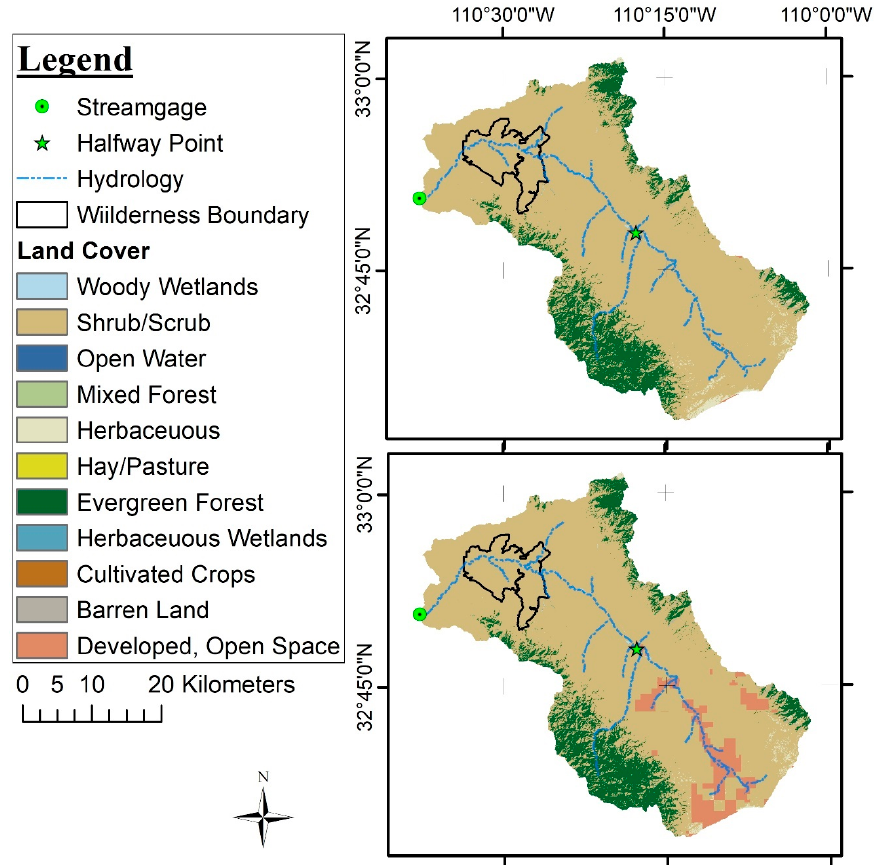
Figure 5. Current ( top ) and developed ( bottom ) land use inputs for SWAT (Soil and Water Assessment Tool) scenario assessment, modified from the NLCD [59].